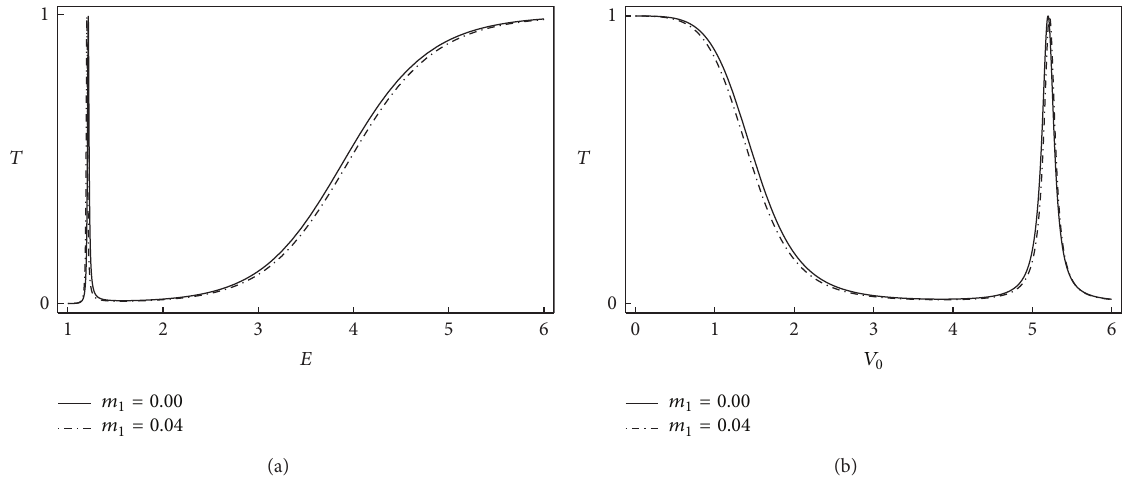
Figure 5: The effect of position dependent mass for the Hulthen potential on transmission coefficient. (a) shows 𝑉 0 = 4 , 𝐿 = 0 , 𝑏 = 1 , 𝑝 = 1 , ̃ 𝑝 = 1 , 𝑞 = 0.5 , ̃𝑞 = 0.5 , and 𝑚